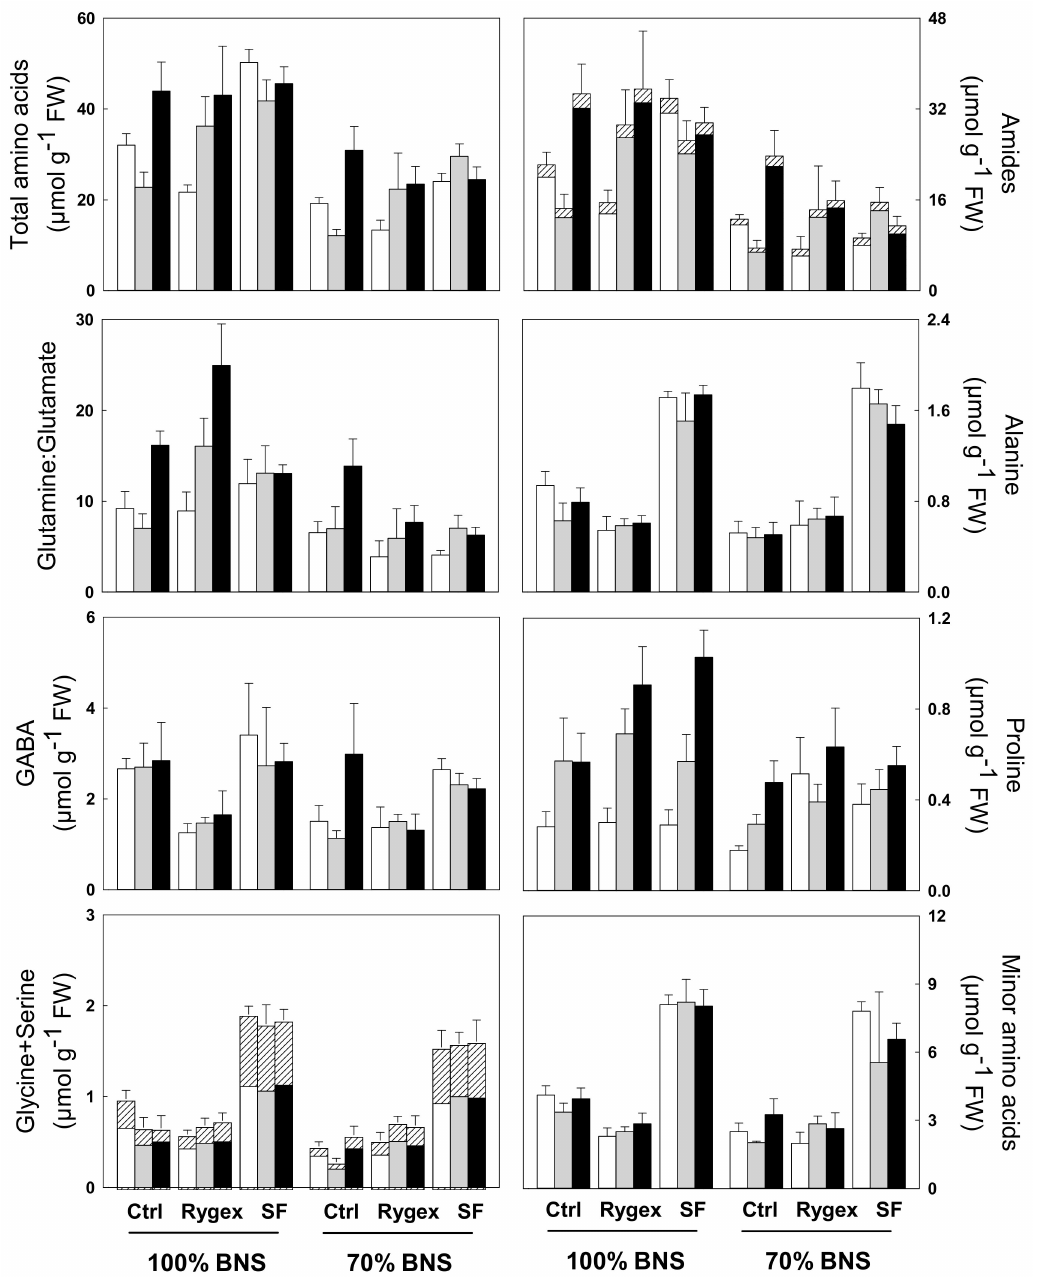
Figure 2. Leaf content of total amino acids, amides (the black and white fine pattern in the bar represents only asparagine), glutamine:glutamate, alanine, GABA, proline, glycine + serine (the black and white fine pattern in the bar represents only glycine), minor amino acids. Bar colors and experimental design are as in Figure 1. The values are mean ± S.D. ( n = 5)). Significance of the main factors (nutrient solution, biostimulant and salinity) and their interactions are shown in Tables 4 and